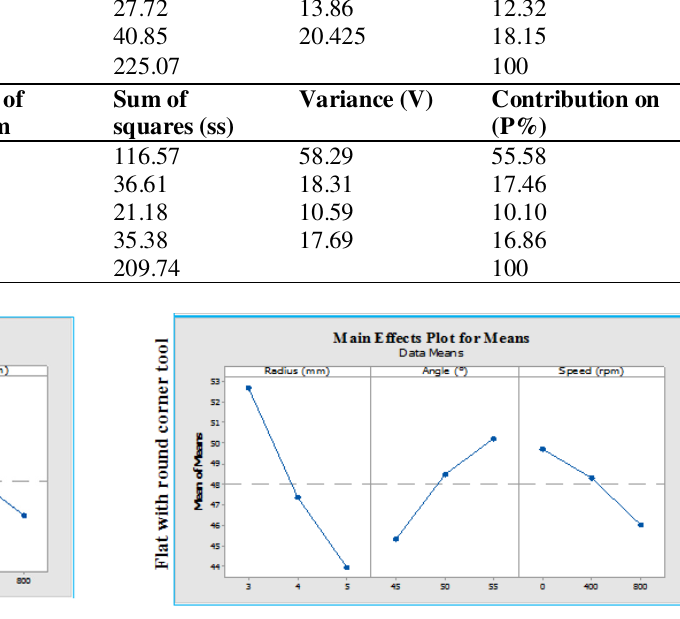
Fig. 11. Relationship between process parameters and mean residual